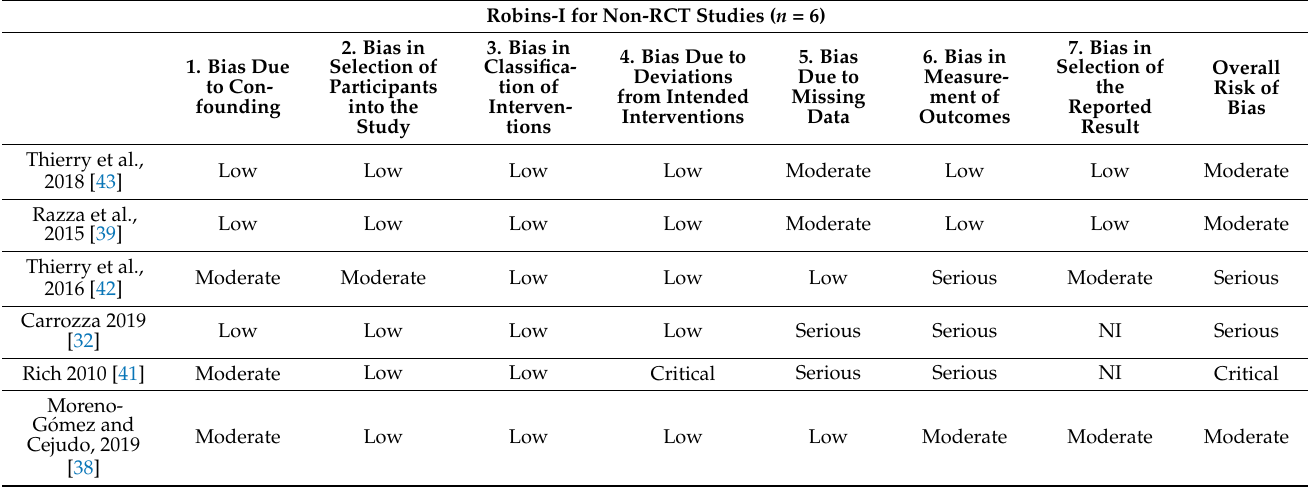
Table A2. Robins-I for non-RCT